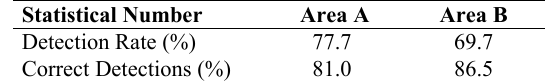
Table 1. Results of the pole detection in the test areas A and B. Targets that were visible in the MLS data, closer than 30 m to